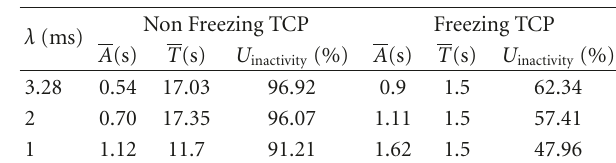
Table 1: Average activity time, average inactivity time and percent- age of